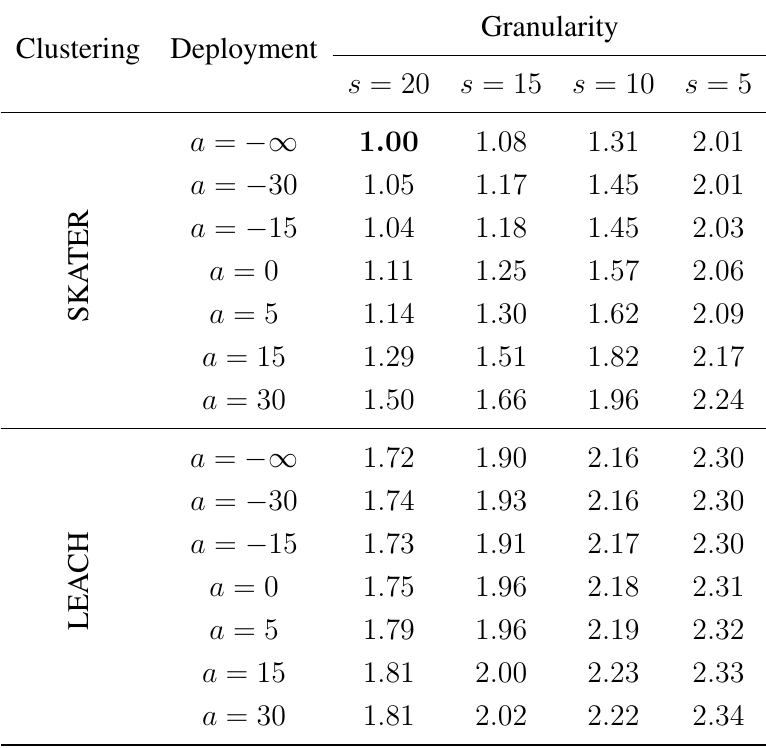
Table 1. Relative errors using reconstruction by